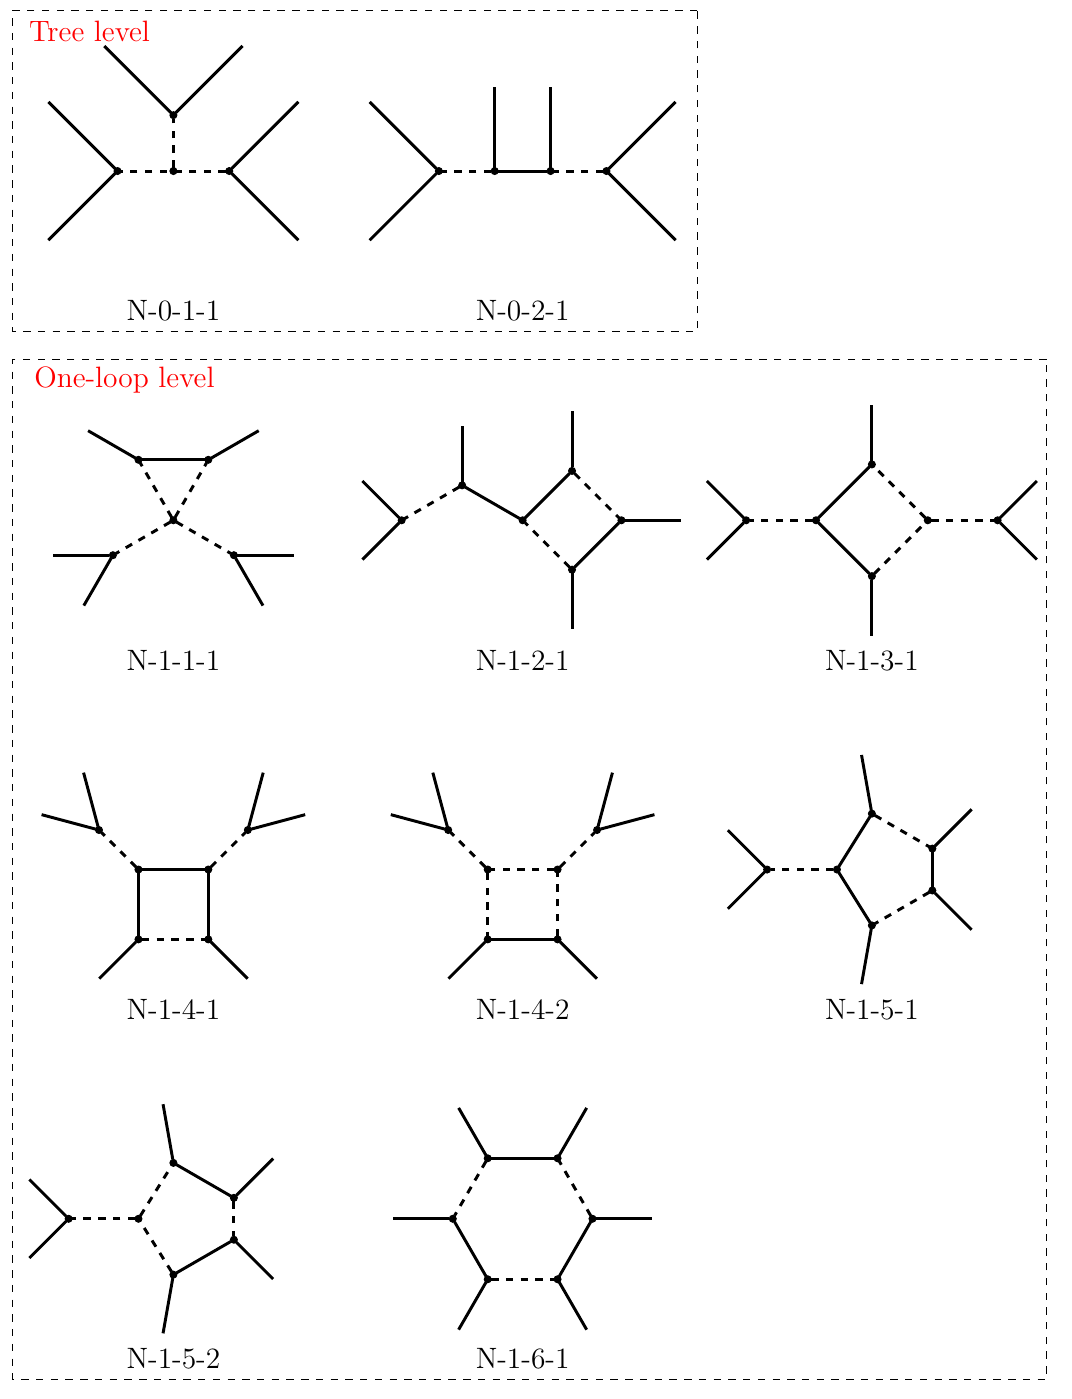
Figure 2 . List of genuine diagrams arising from the topologies in figure 1, where the solid and dashed lines stand for fermion and scalar fields